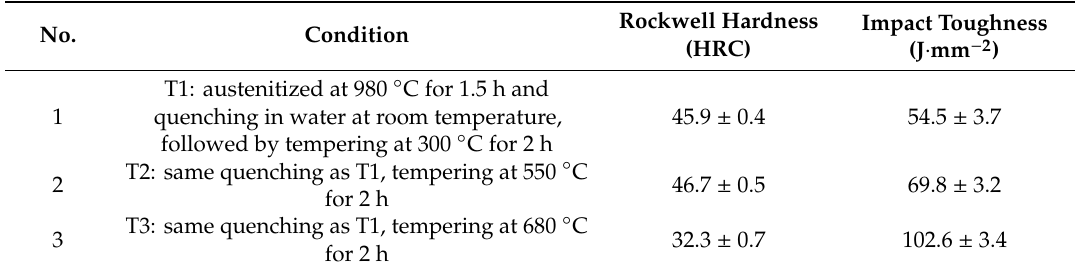
Table 1. Heat treatment conditions and mechanical properties of the